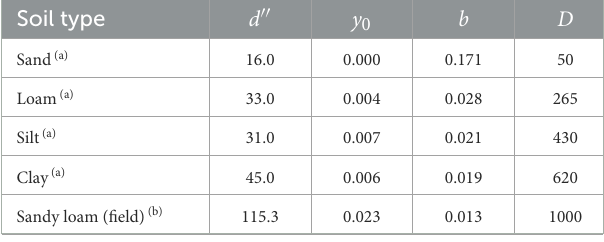
TABLE 1 Parameters of Equation (8) of: (a) standard soil type (Shah et al., 2007); and (b) La Mata catchment soil type (Balugani et al.,